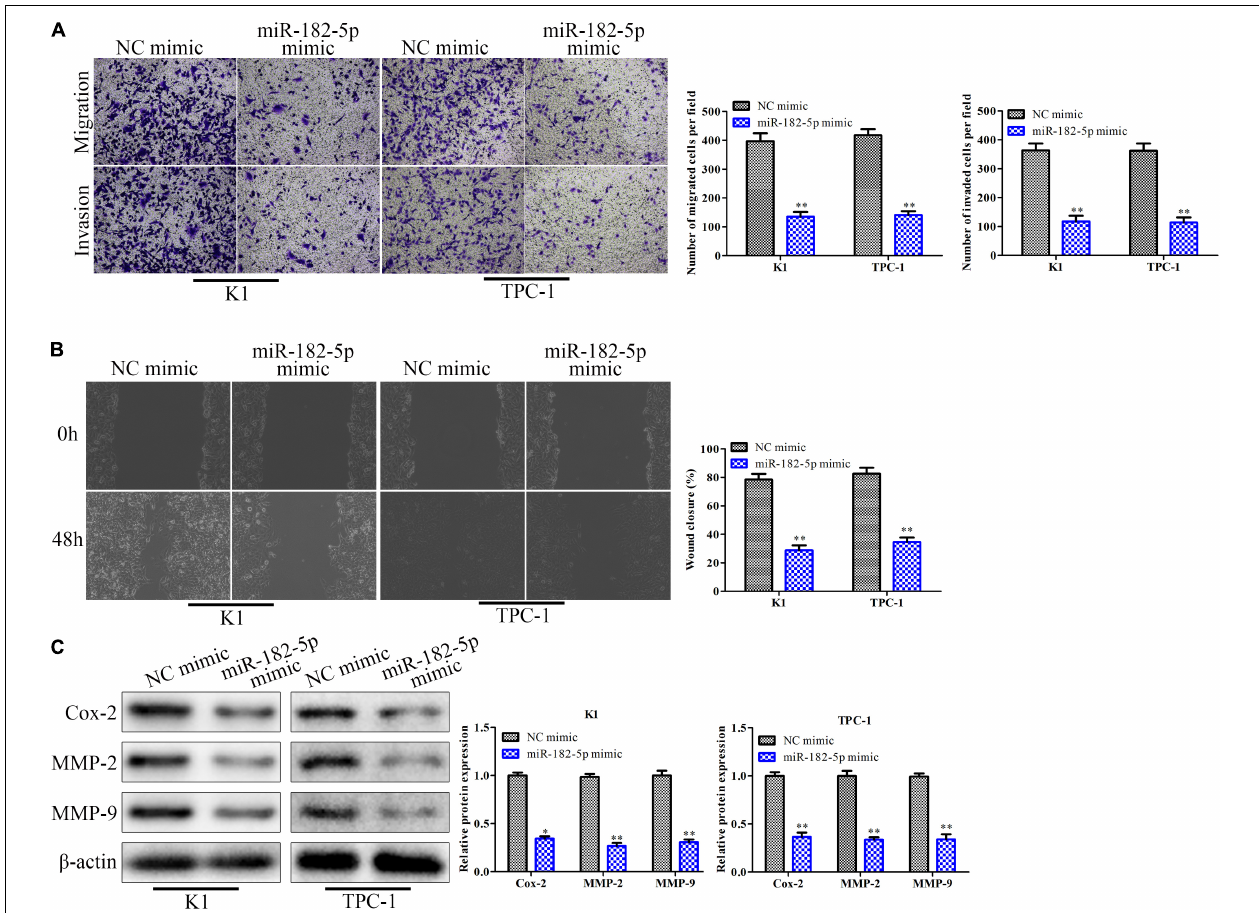
FIGURE 4 | Overexpression of miR-182-5p suppresses migration and invasion of thyroid cancer cells in vitro . K1 and TPC-1 cells were transfected with either miR-182-5p mimic or NC mimic. (A) Transwell chamber assay for cell migration and invasion. (B) Cell capacity of migration (scratch test). (C) Western blot analysis of the expression level of migration related proteins (Cox-2, MMP-2, and MMP-9). * P < 0.05, ** P < 0.01 vs. the NC mimic group. The data were presented as mean ± SD and the experiments were repeated 3